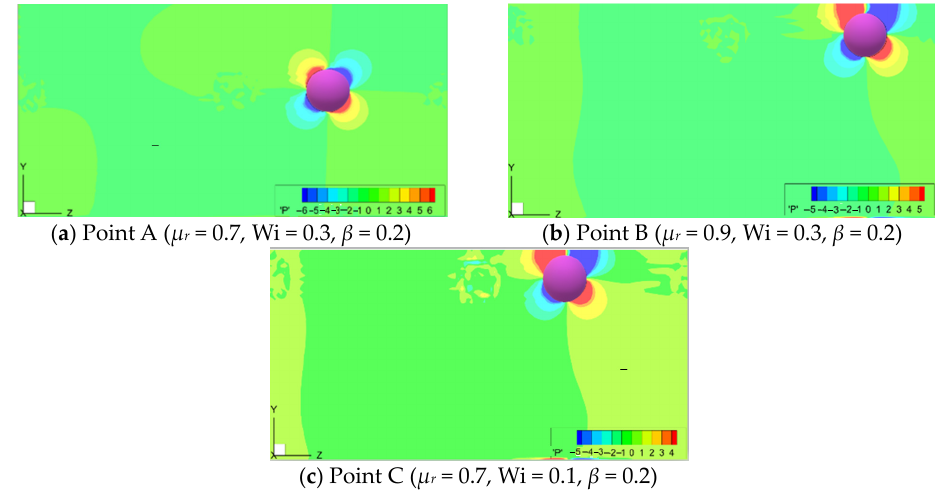
Figure 7. Pressure contours for three cases in Figure 6 ( α =